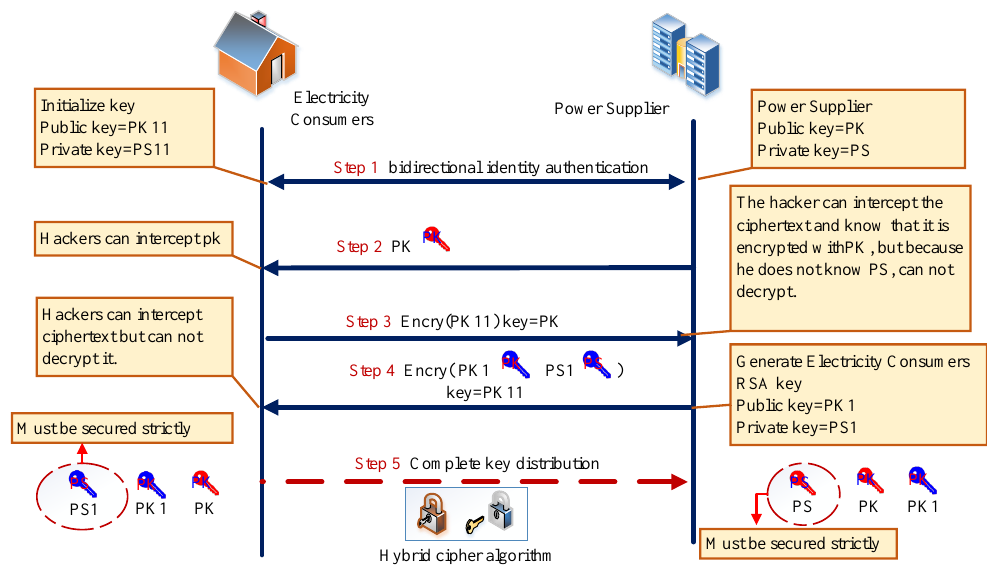
Figure 6. Key distribution and management.